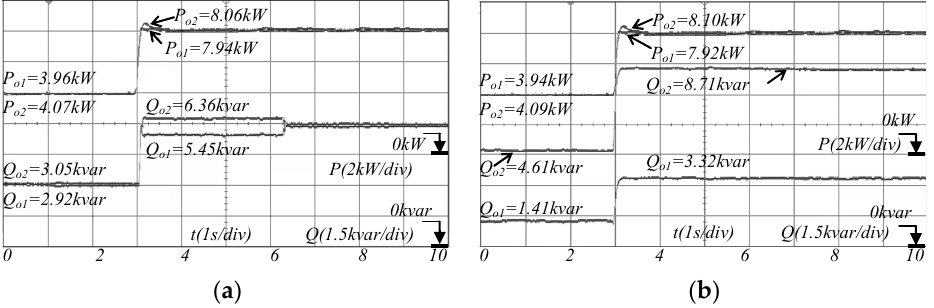
Figure 14. The waveforms of the active and reactive power in experiment III: ( a ) The proposed method; ( b ) The traditional method.